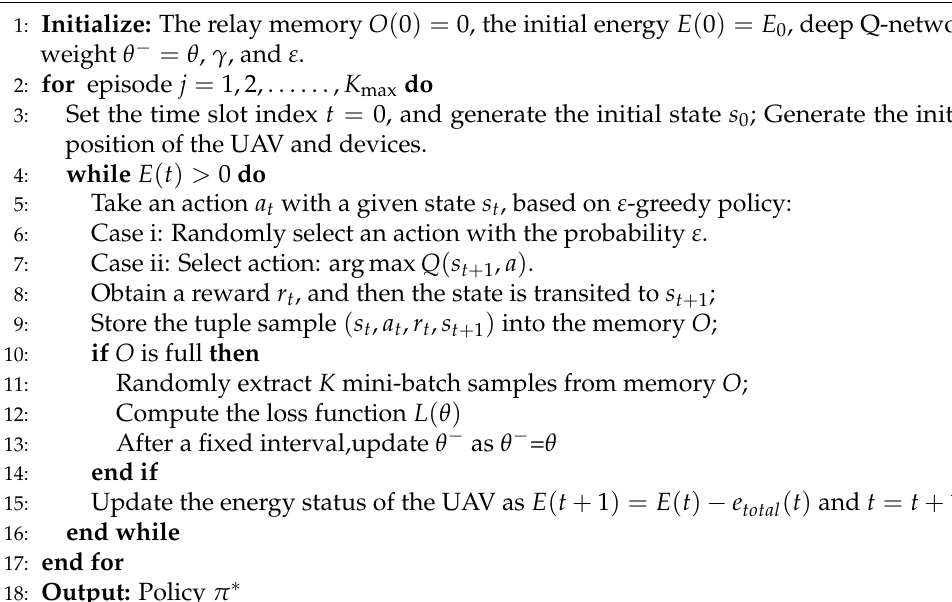
Algorithm 1 DDQN-based freshness-aware path planning